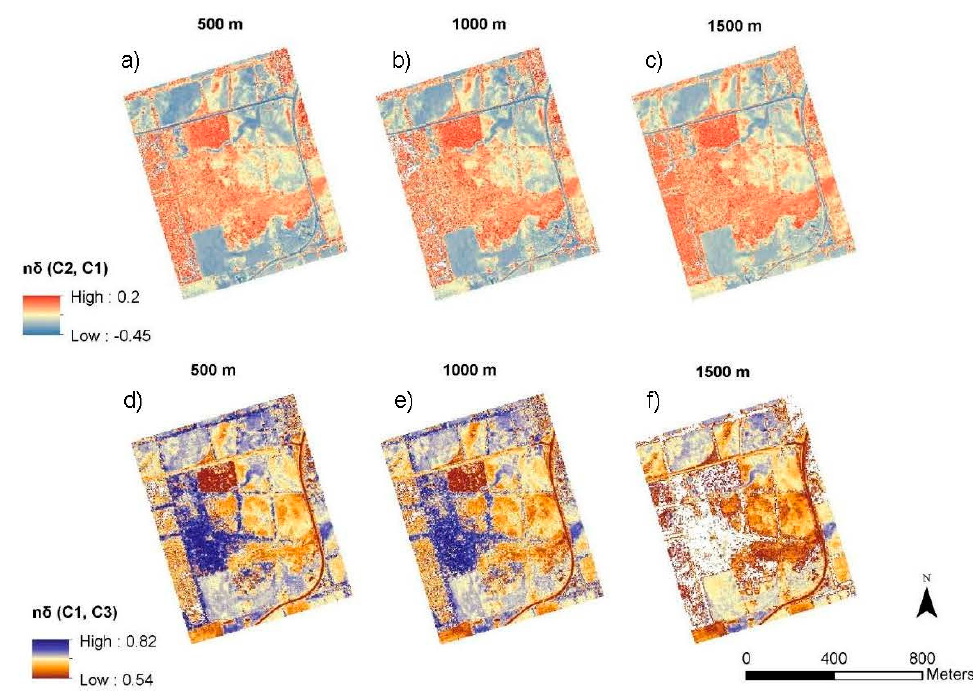
Figure 8. n δ (C2, C1) and n δ (C1, C3) for single returns, averaged over 4 m × 4 m grid. White pixels represent no data.